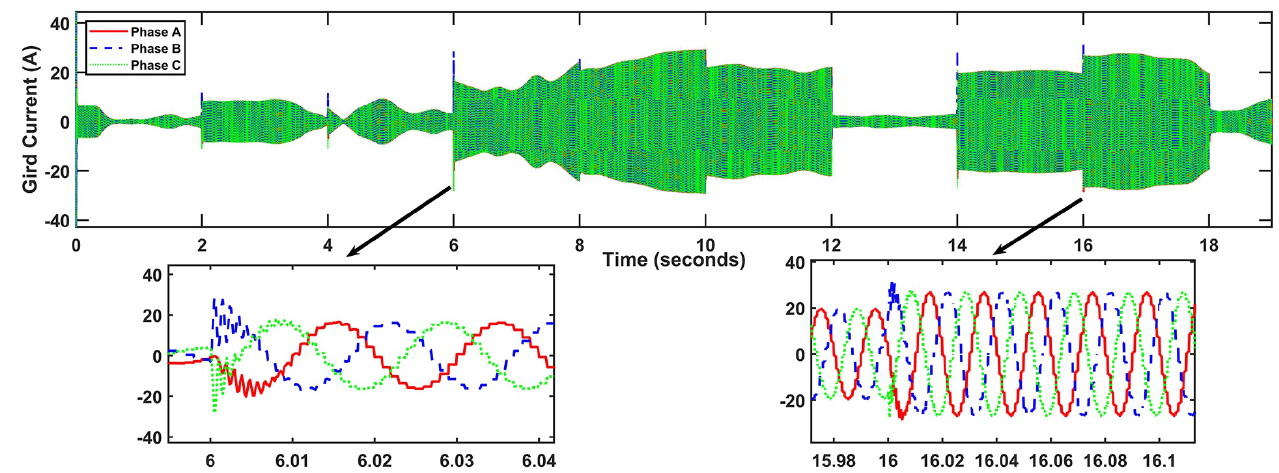
Figure 15. Grid current during grid-connected